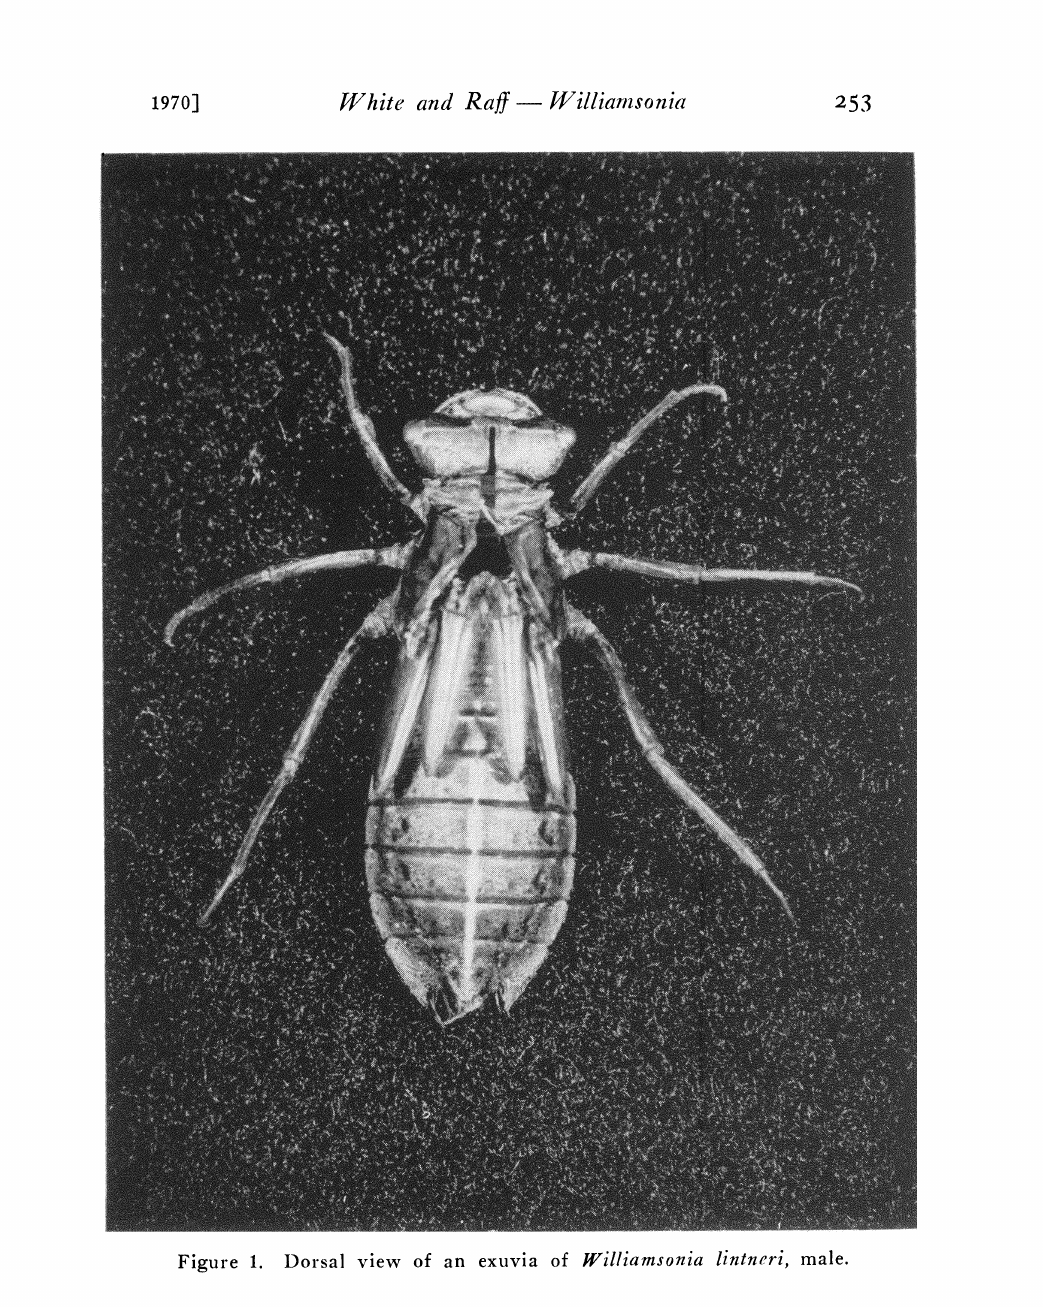
Figure 1. Dorsal view of an exuvia of IVilliamsonia lintneri,